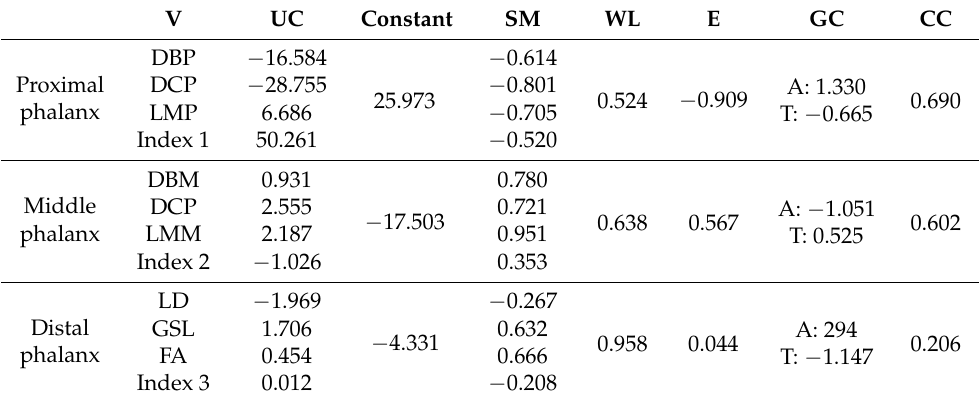
Table 3. Stepwise discriminant function analysis for Arabian horses and thoroughbred horses.